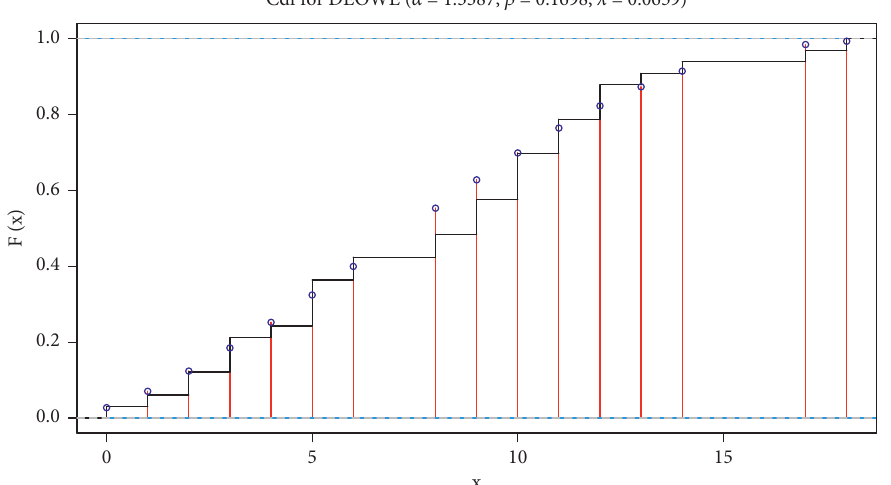
Figure 14: Graphical plots of the data and the CDF, as we can see in the plot, is the distributions with the random variable with value x , where x is the number of deaths per day.